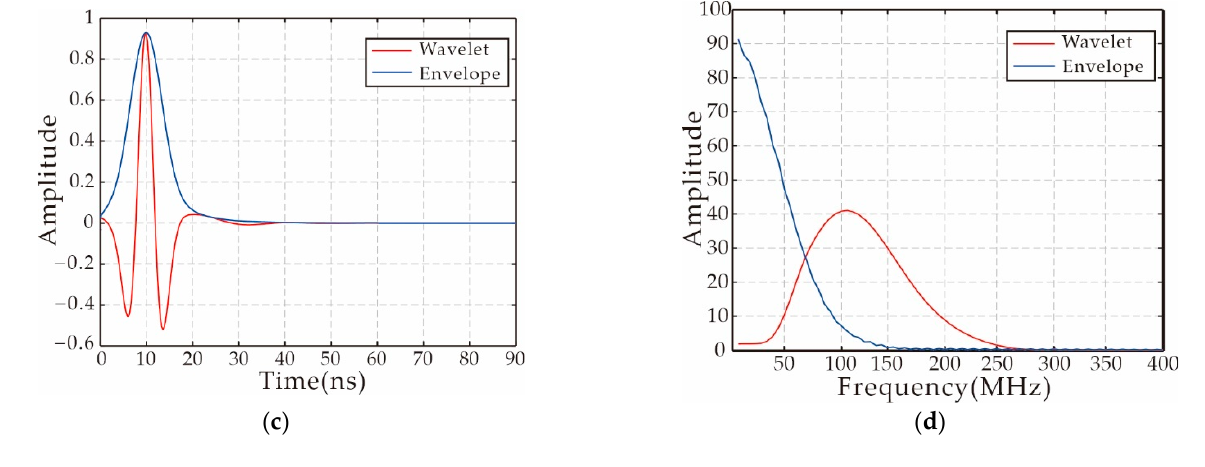
Figure 3. Spectrum analysis diagram before and after envelope transformation: ( a ) Ricker wavelet and its envelope; ( b ) spectra of Ricker wavelet and its envelope. ( c ) Ricker wavelet without low- frequency data and its envelope; ( d ) spectra of Ricker wavelet without low-frequency data and its envelope.